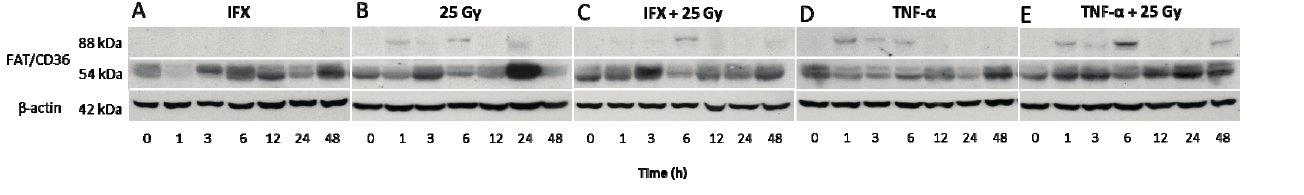
Figure 4. Western blot analysis of fatty-acid-translocase/cluster of differentiation protein 36 (FAT/CD36) from total protein extracts of mice livers. infliximab (IFX)-treated ( A , IFX); irradiated ( B , 25 Gray(Gy)); IFX-treated and irradiated ( C , IFX + 25 Gy); TNF- α -treated ( D , TNF- α ); and TNF- α -treated and irradiated ( E , TNF- α + 25 Gy) mice samples were analyzed by using anti-FAT/CD36 antibody at different time points. Two bands, ~88 (active isoform) and ~54 (inactive isoform), were detected. β -actin was used as loading control. Results are representative for three